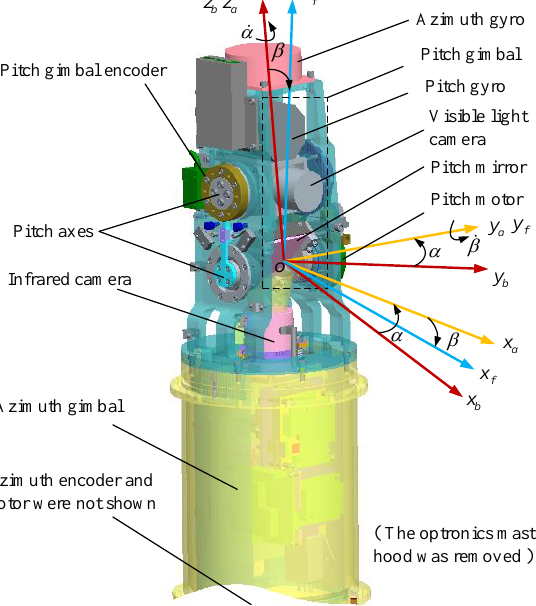
Figure 1. The 3D model of optronic mast and corresponding coordinate